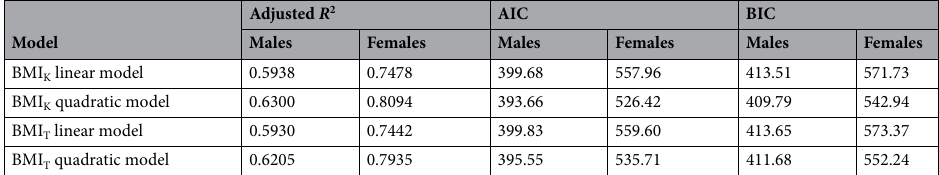
Table 6. Summary of adjusted R 2 values, Akaike information criterion (AIC) and Bayesian information